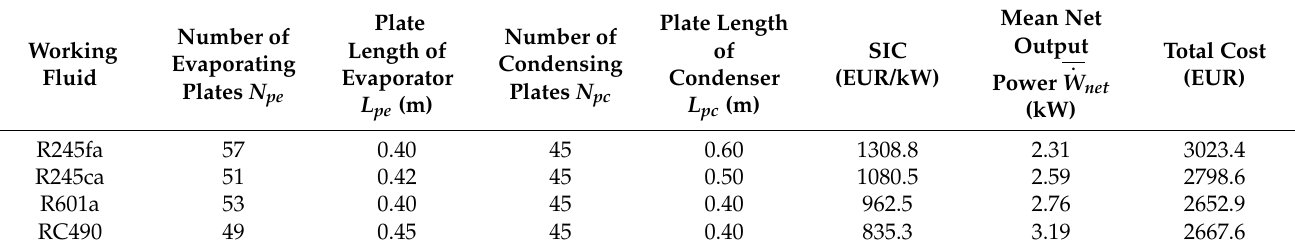
Table 10. The optimal geometric parameters and the values of